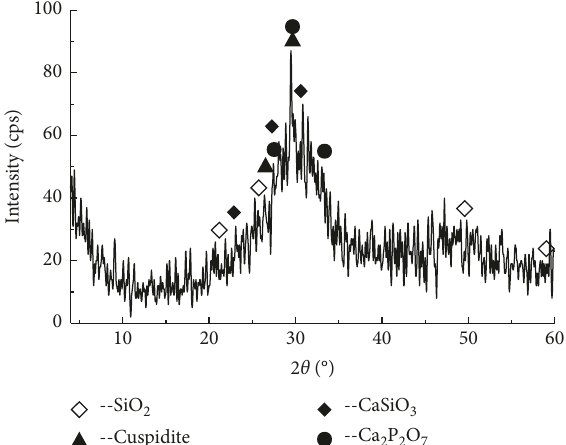
Figure 4: XRD pattern of phosphorus slag